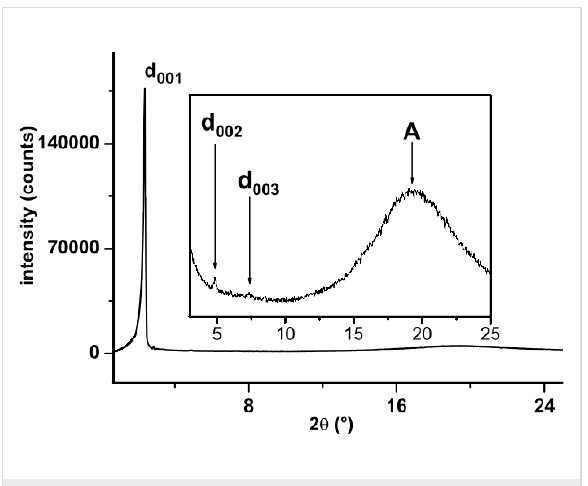
Figure 6: Diffraction small-angle X-ray pattern of the smectic phase of 2 12 recorded at T = 100 °C.